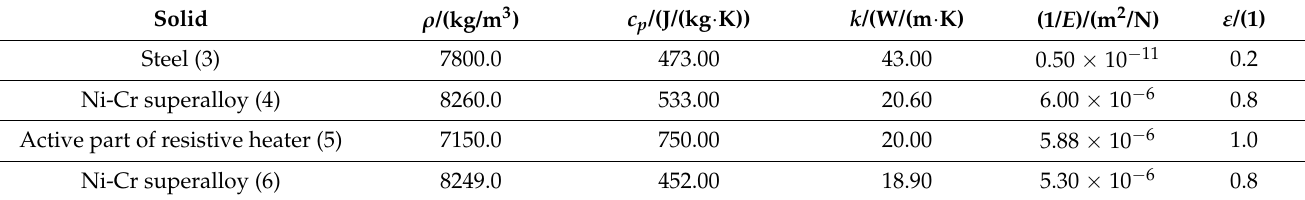
Table 3. Material properties of solids in simulation of temperature distribution and fluid flow.